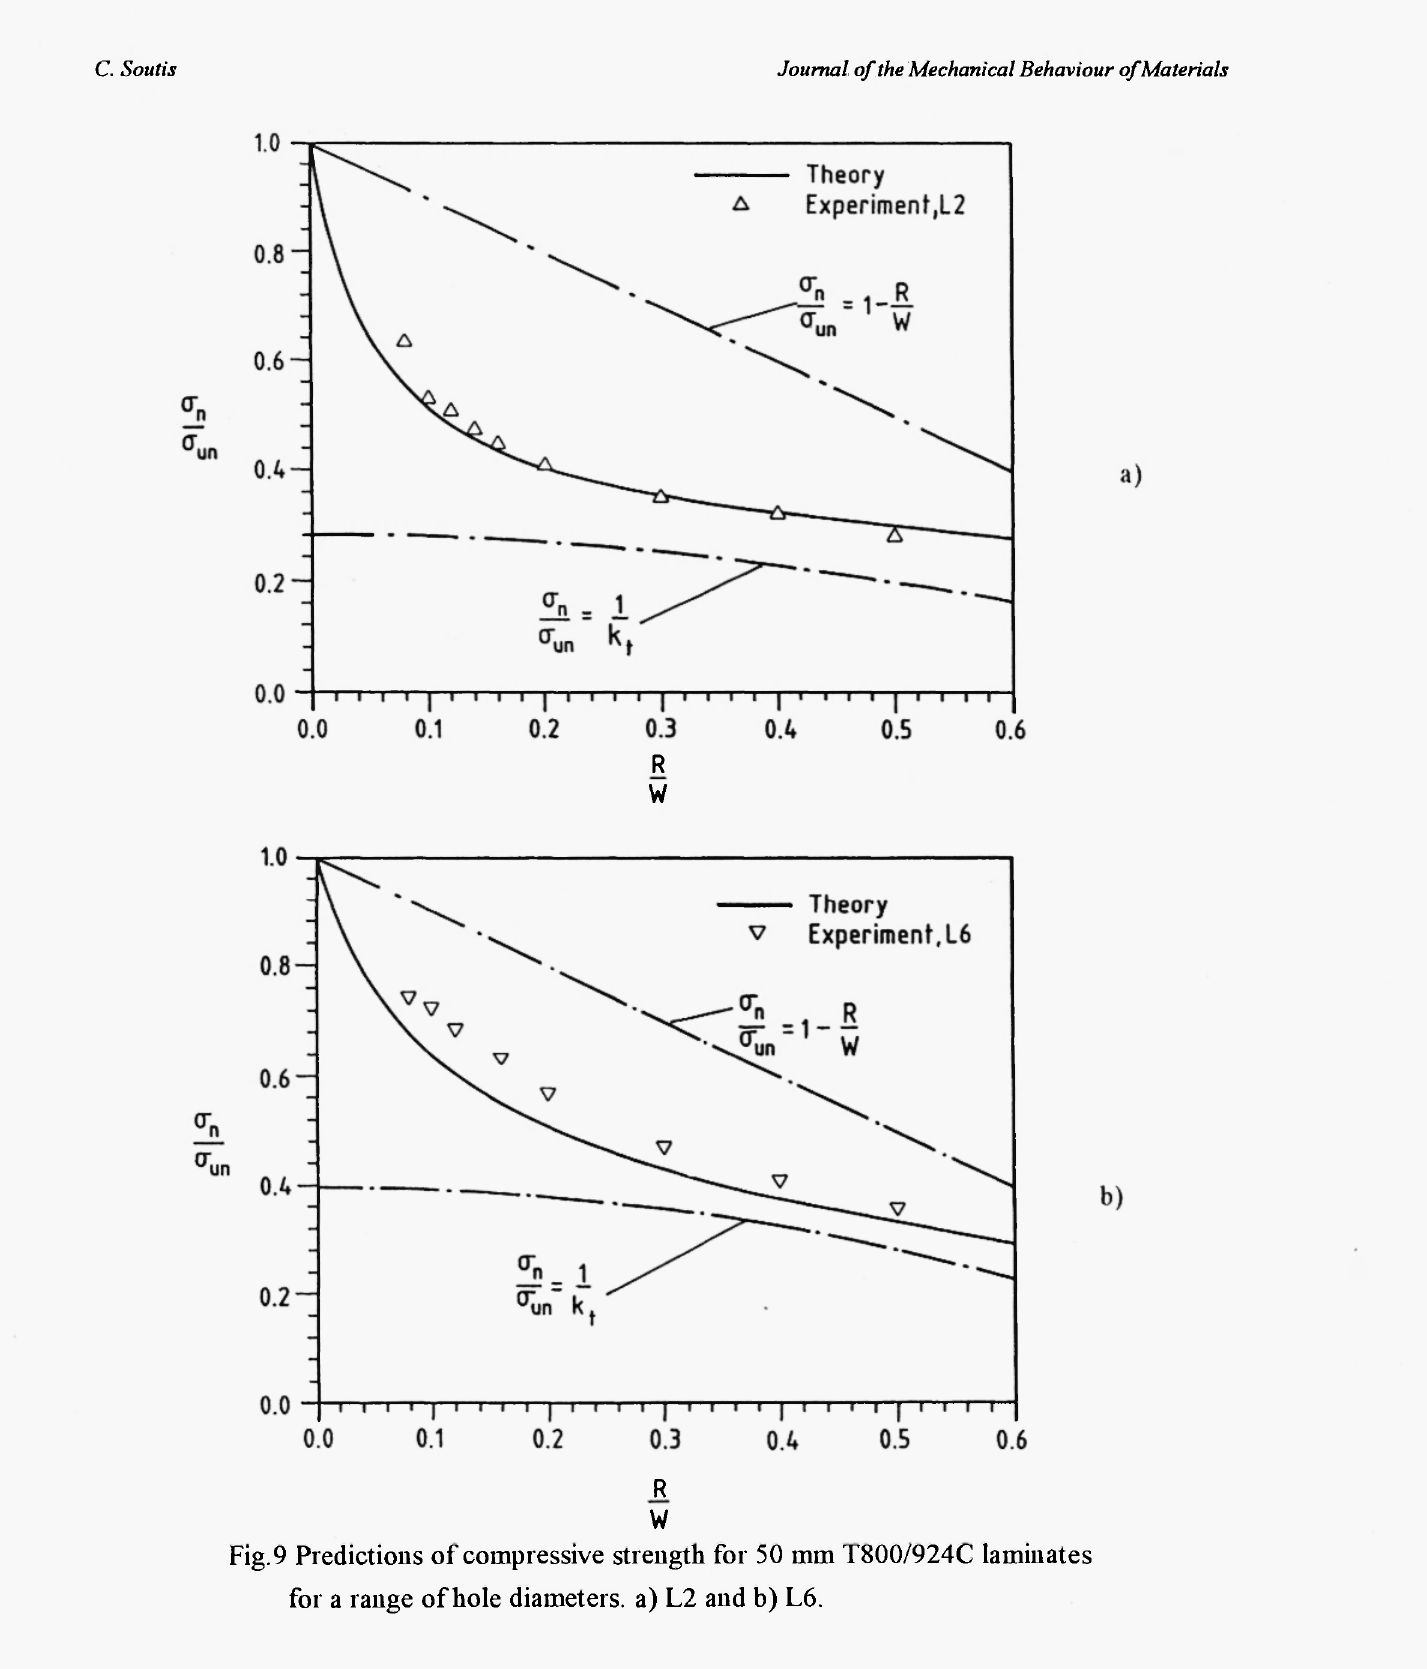
Fig.9 Predictions of compressive strength for 50 mm T800/924C laminates for a range of hole diameters, a) L2 and b)